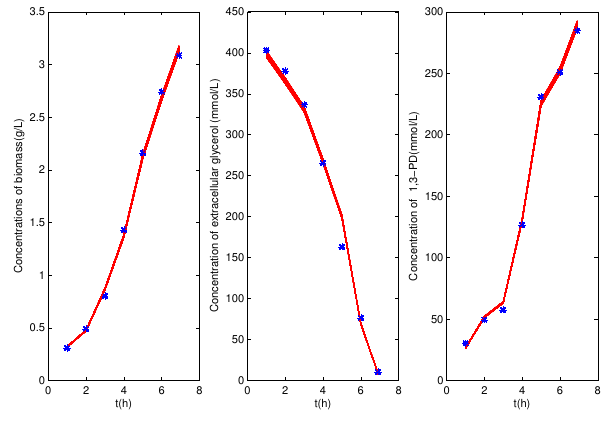
Figure 1. Comparison of biomass, glycerol, 1,3-PD concentration between experimental data and computational results x ( t,x 1